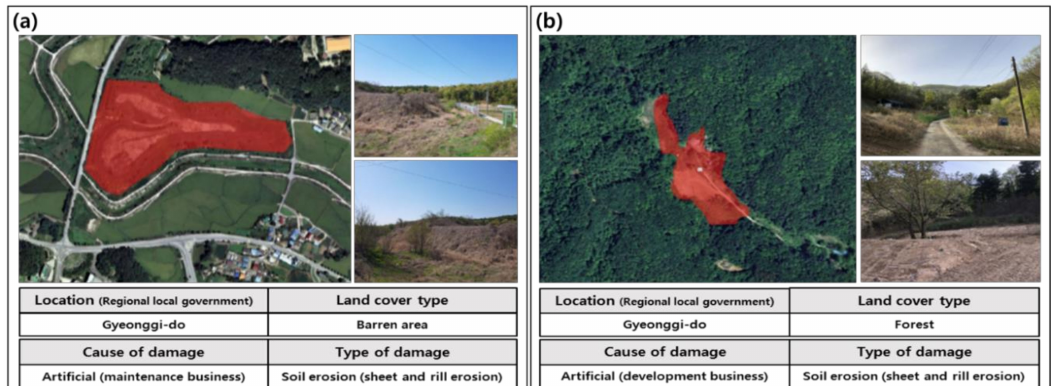
Figure 8. Examples of actual damage status derived through field surveys: ( a ) Damaged area where soil erosion occurred due to maintenance businesses in Gyeonggi-do; ( b ) Damaged area where soil erosion occurred due to development businesses in